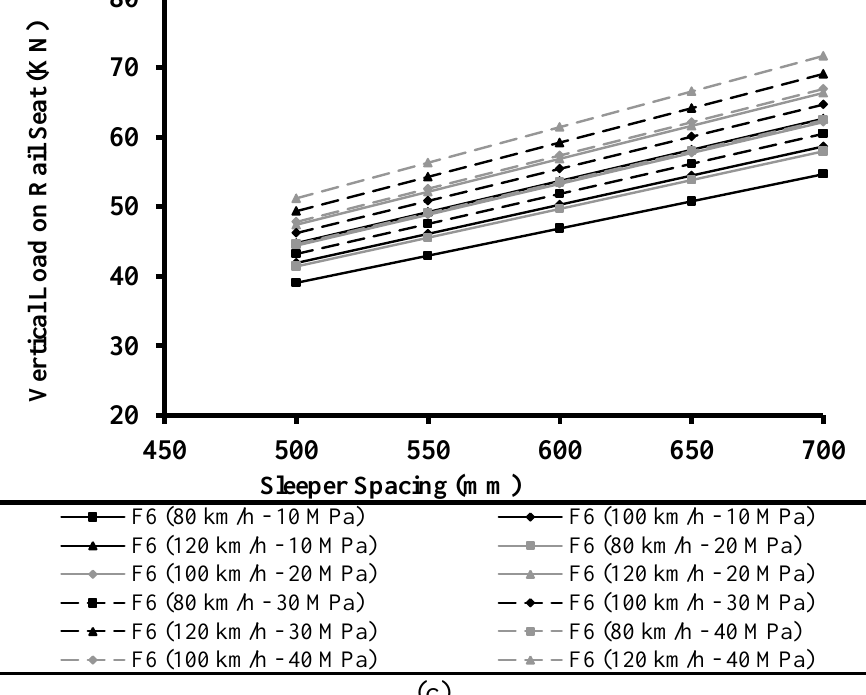
Fig. 7. Variations of vertical load on rail seat for a) passenger train, b) 4- axles freight train, c) 6- axles freight